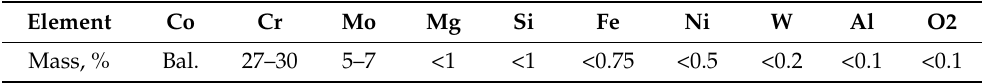
Table 1. Chemical compositions of Co-Cr-Mo alloy